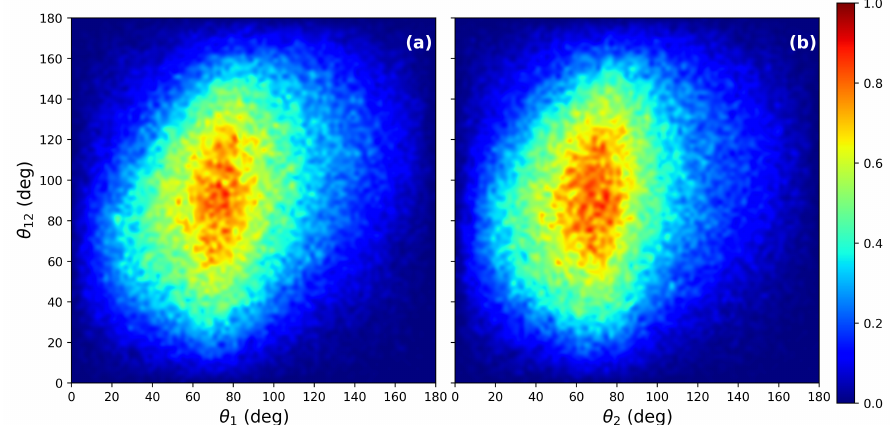
Figure 2. Normalized contour plots for the interelectronic angle θ 12 between the first and the second emitted electron as a function of their respective polar angles θ 1 ( a ) and θ 2 ( b ) as provided by the Ad-CTMC